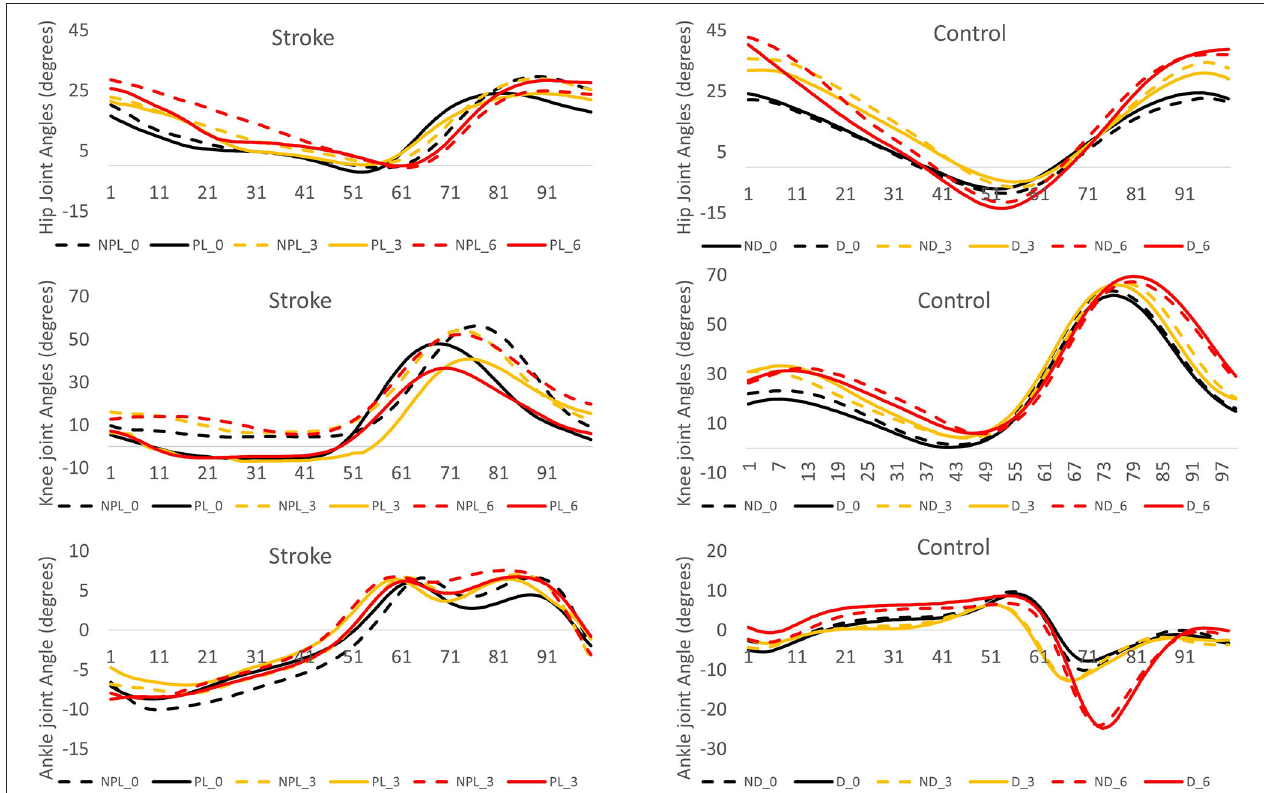
FIGURE 2 | The angle displacement of the hip, knee, and ankle during the gait cycle (expressed in percentage) in the stroke group and control group. The positive values indicate the hip and knee flexion and ankle dorsiflexion. NPL_0: non-paretic leg at 0 ◦ incline (black dash line), PL_0: paretic leg at 0 ◦ incline (black solid line), NPL_3: non-paretic leg at 3 ◦ incline (yellow dash line), PL_3: paretic leg at 3 ◦ incline (yellow solid line), NPL_6: non-paretic leg at 6 ◦ incline (red dash line), PL_6: paretic leg at 6 ◦ incline (red solid line), ND_0: non-dominant leg at 0 ◦ incline (black dash line), D_0: dominant leg at 0 ◦ incline (black solid line), ND_3: non-dominant leg at 3 ◦ incline (yellow dash line), D_3: dominant leg at 3 ◦ incline (yellow solid line), ND_6: non-dominant leg at 6 ◦ incline (red dash line), D_6: dominant leg at 6 ◦ incline (red solid